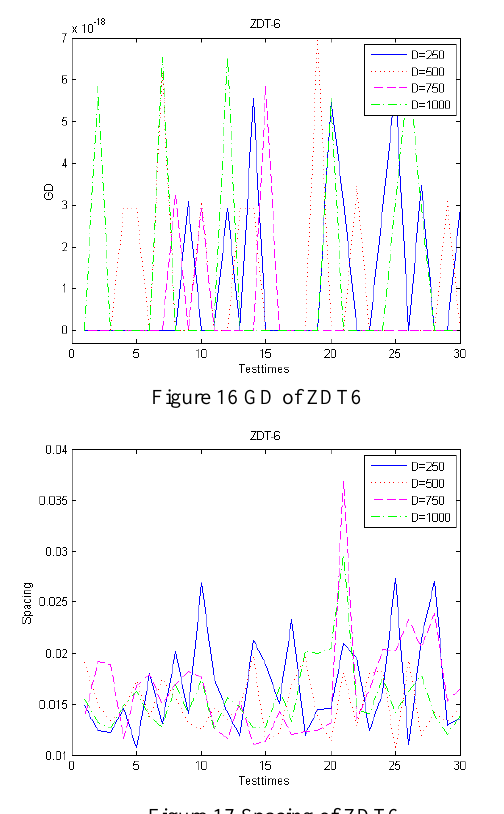
Figure 17 Spacing of ZDT6 Figure 13 Spacing of ZDT4 The benchmark function ZDT1 and ZDT2 are relatively simple. Most MOPSOs can solve the two problems with 30 decision variables (Tables and figures for 10~100D are omitted in this paper). Not only can CEPSO solve ZDT1 and ZDT2 with 30 decision variables but also problems with up to 1000 decision variables. The simulation results for the high dimensional problems are given in Table 2~3 and Figure 2~9. As can be seen from these tables and figures, for the metric of SNA, there is a little change in number. The GD is negligibly tiny to 10 -19 , which means that PF known is almost unlimitedly near PF . On the other hand, the true Figure 14 Pareto front of ZDT6(D=1000) Spacing is stable and there is no difference among various dimensions, but the Spacing of ZDT1 is better than that of ZDT2. The benchmark function ZDT4 and ZDT6 are more difficult than ZDT1 and ZDT2. Again, not only can CEPSO solve ZDT2 and ZDT4 with 30 decision variables but also solve problems with up to 1000 decision variables. The benchmark function ZDT4 has 21 9 local optima and most MOPSOs are easily trapped in them. The simulation results for the high dimensional problems are given in Table 4 and Figure 10~13. As can be seen, for the metric of SNA, there is some changes in number. However, the least is 38, which is a reasonable result. The GD is very tiny and is about 10 -19 . Figure 15 SNA of Most runs can obtain true Pareto front. On the other hand, the Spacing is stable and there is no difference among various dimensions.